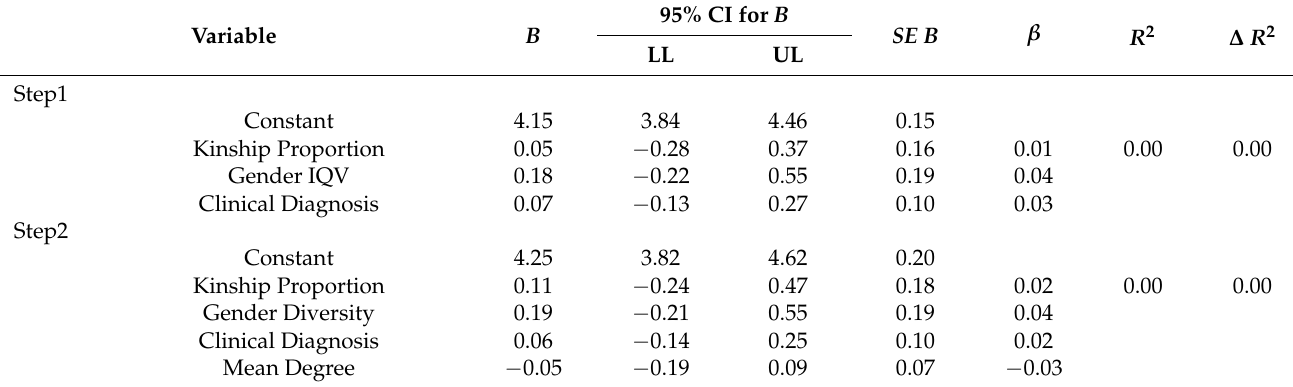
Table 5. Hierarchical linear regression results for depression mitigation behaviors: evaluating the role of mean